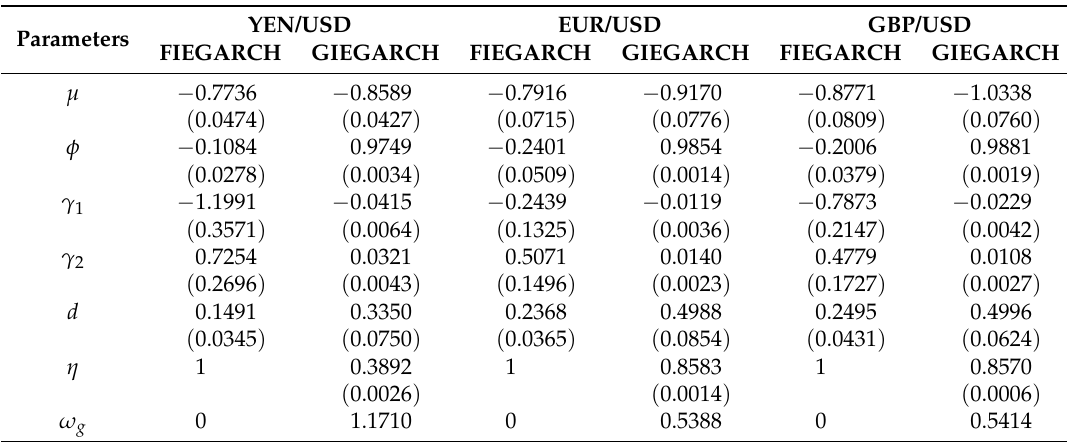
Table 4. QML Estimates of FIEGARCH and GIEGARCH Models.